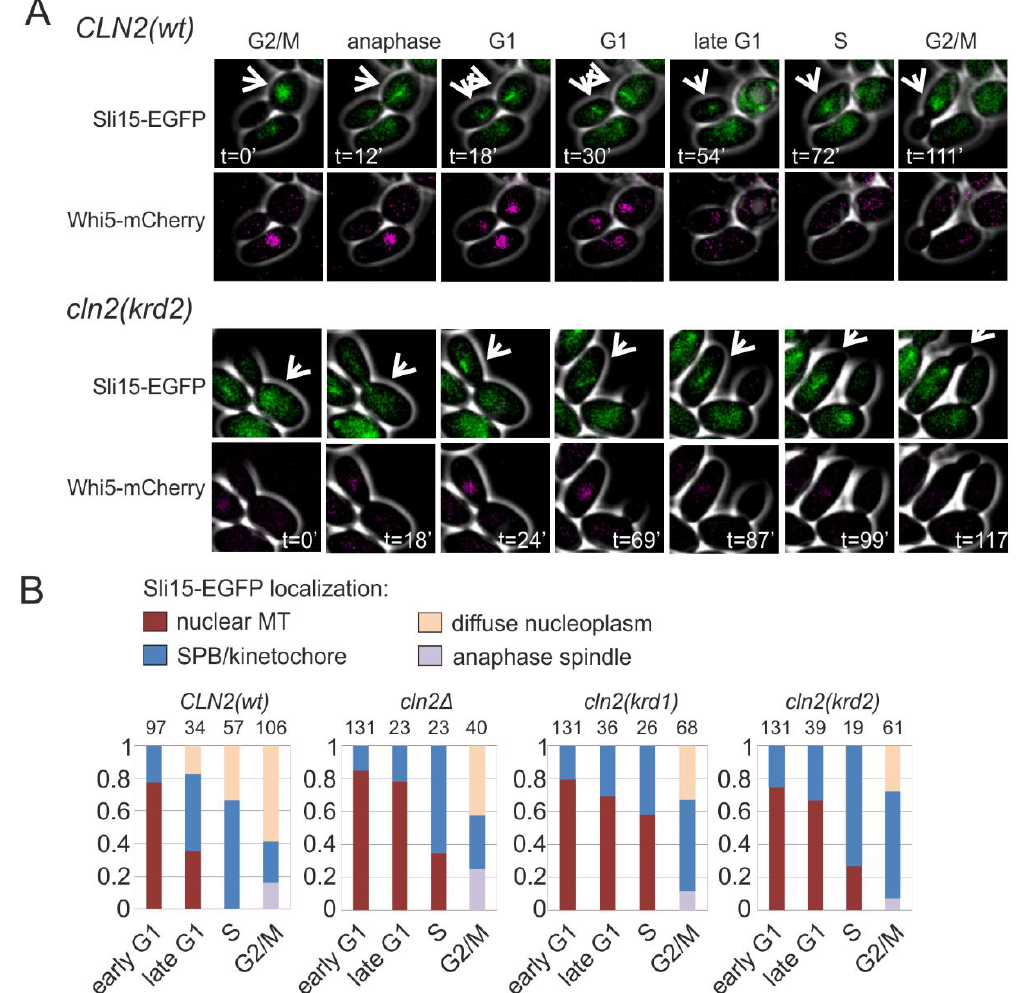
Figure 5. K/R docking regulates Sli15 localization dynamics . ( A ) Images showing the subcellular localization of Sli15-GFP during the cell cycle in cells expressing Cln2(wt) or Cln2(krd2). The nuclear localization of Whi5-mCherry was used as the reference for cell cycle progression. ( B ) Plots showing the fraction of cells with the indicated Sli15-GFP localization. Early G1 cells were unbudded cells with nuclear Whi5-mCherry, whereas late G1 cells were unbudded but without nuclear Whi5-mCherry signal. Small budded cells were denoted as S phase and large budded cells were categorized as G2/M cells. The experiments were performed using cln1 ∆ cln2 ∆ strains expressing the indicated CLN2 variant under CLN2 promoter on a centromeric plasmid.